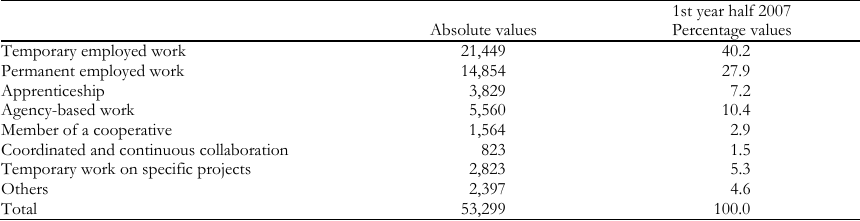
Job placements according to contract type during the first half of 2007